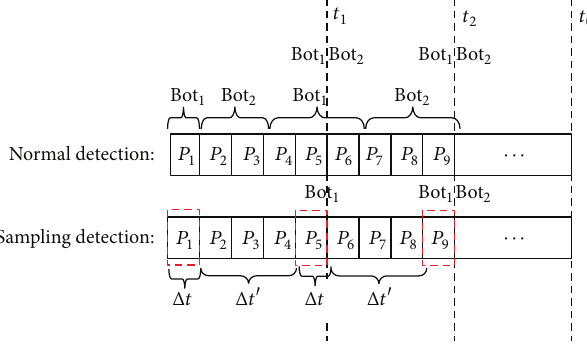
Table 2: Features for node-based analysis.